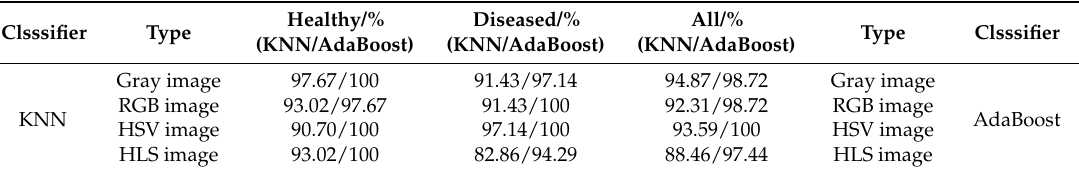
Table 7. Comparison of the testing results based on different types of